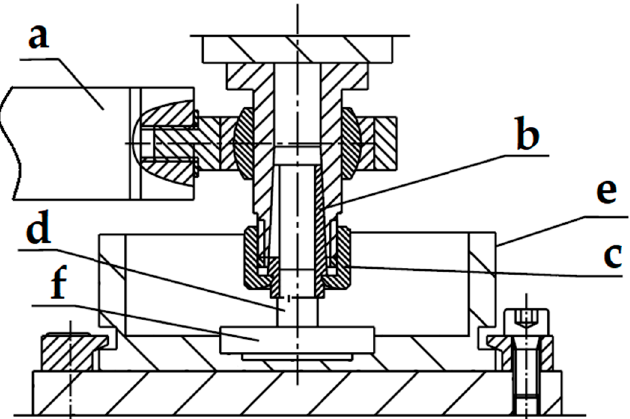
Figure 2. Diagram of the friction junction of the T-17 tester: (a) Force sensor, (b) collet, (c) clamping nut, (d) upper pin, (e) reservoir, (f) plate.